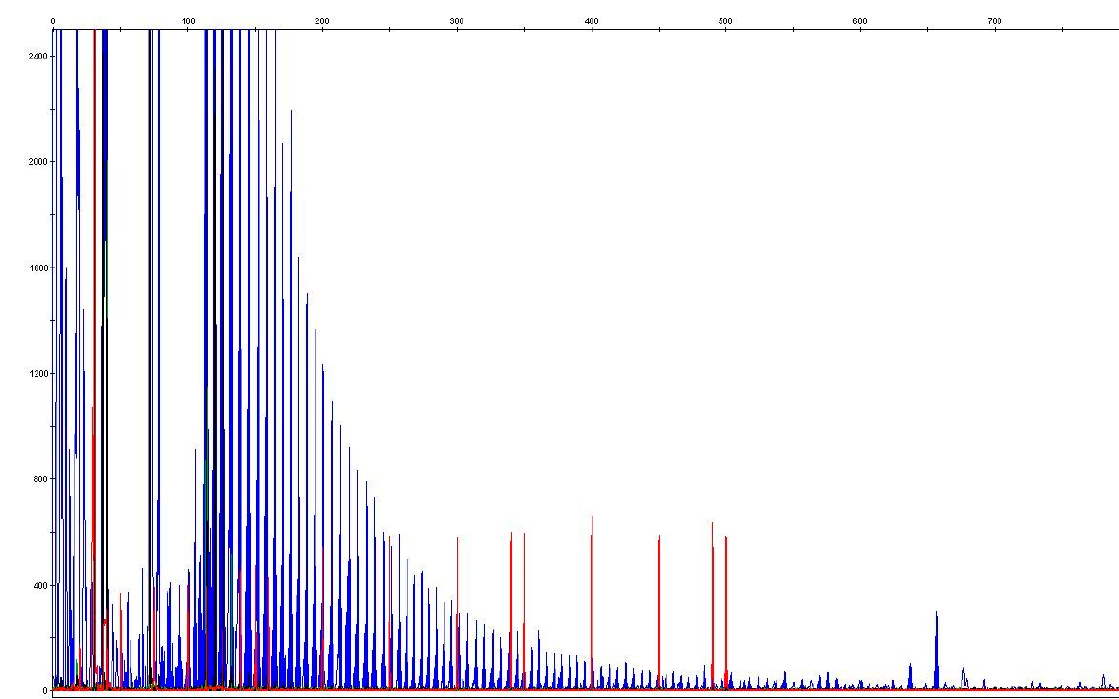
Figure 3. Determination of copy number of hexanucleotide expansion of C9orf72. Reference values: Normal allele <20 GGGGCC repeats, permuted allele 20–100 GGGGCC repeats, complete penetrance> 100 GGGGCC repeats. The blue arrow indicates the location of 20 GGGGCC repeats and the red arrow indicates the location of 30 or more repeats.